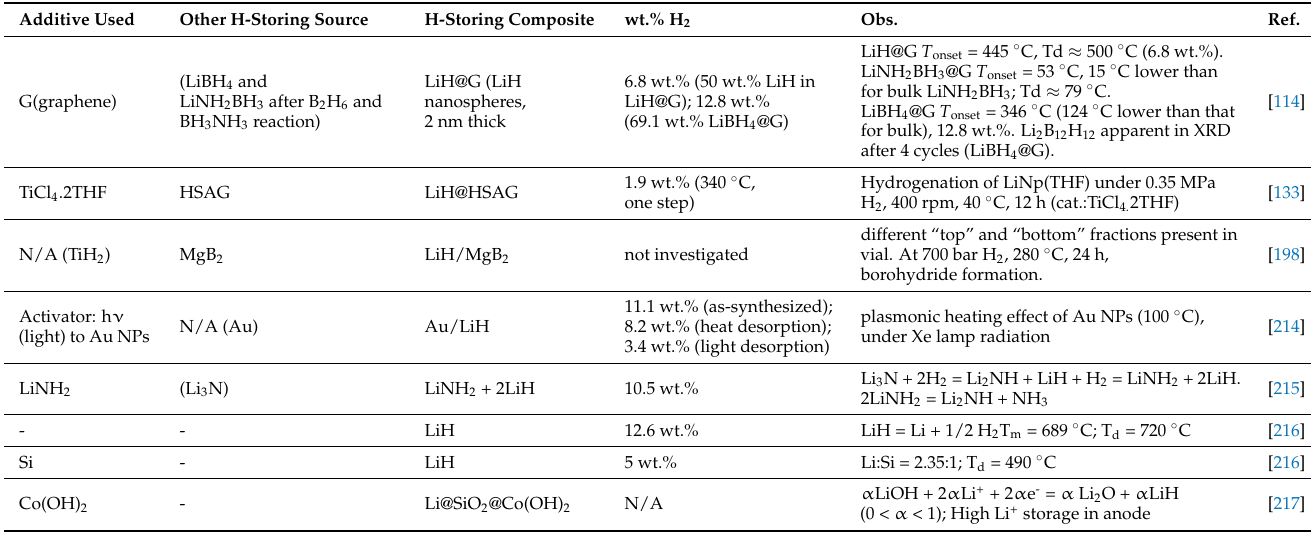
Table 10. Hydrogen storage features of nanosized LiH